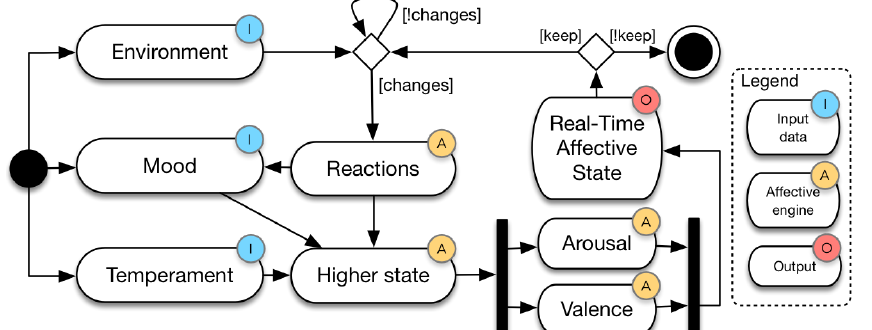
Figure 2. Architecture of the